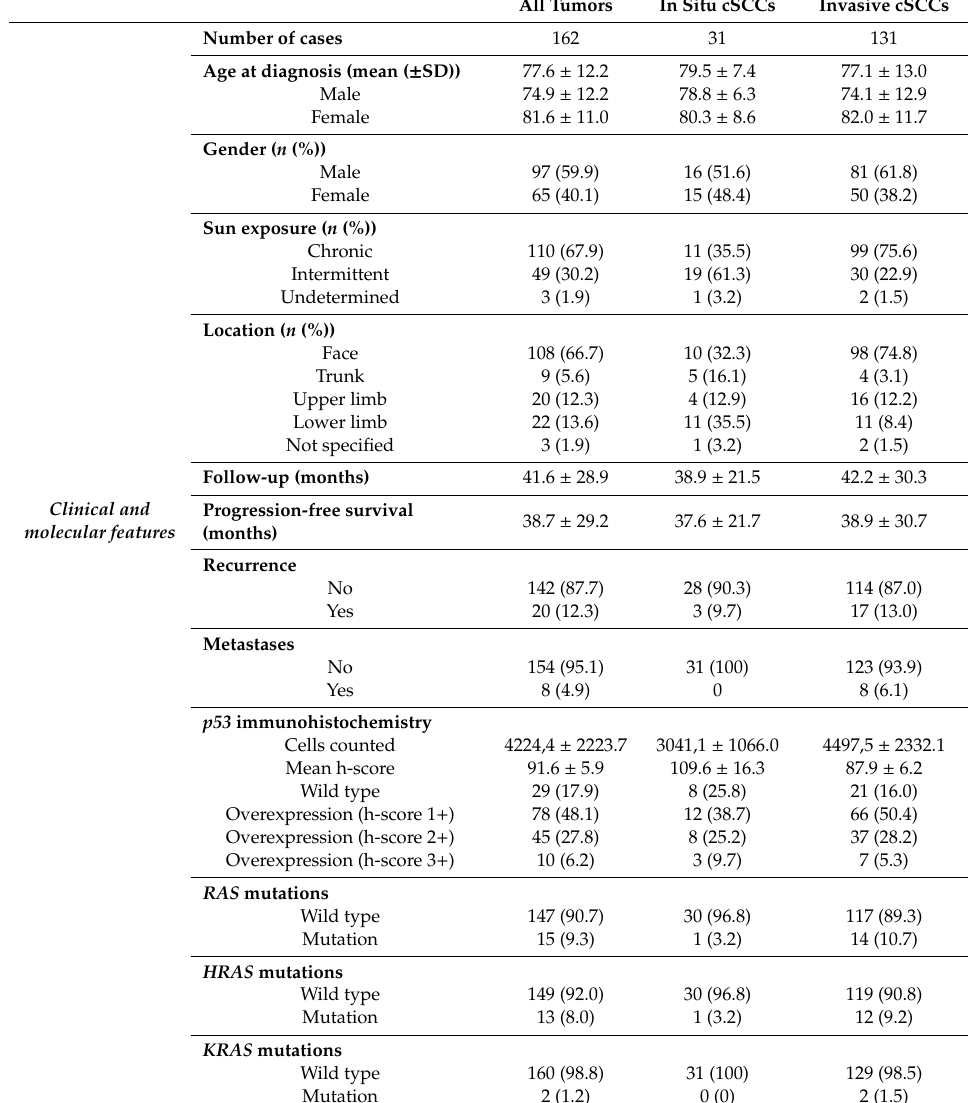
Table 1. Clinicopathological features, frequency of RAS mutations, and p53 expression. All Tumors In Situ cSCCs Invasive